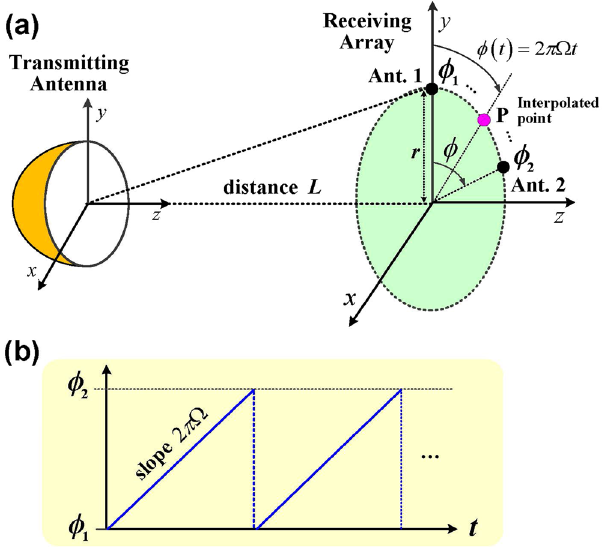
Figure 2. Interpolation of the antenna array signals. ( a ) Schematic of the interpolation algorithm. The OAM wave is detected using two antennas deployed transversely across the doughnut-shaped beam. These two antenna signals are multiplied by weighting coefficients and added together. This interpolated signal has the characteristics of a signal that would be received by an antenna positioned at a point between the two antennas. By varying the weighting coefficients with time, the location of the interpolated point can be made to move from one antenna to the other. ( b ) The rotation angle of the interpolated point P which rotates between Ant. 1 and Ant. 2 with speed Ω